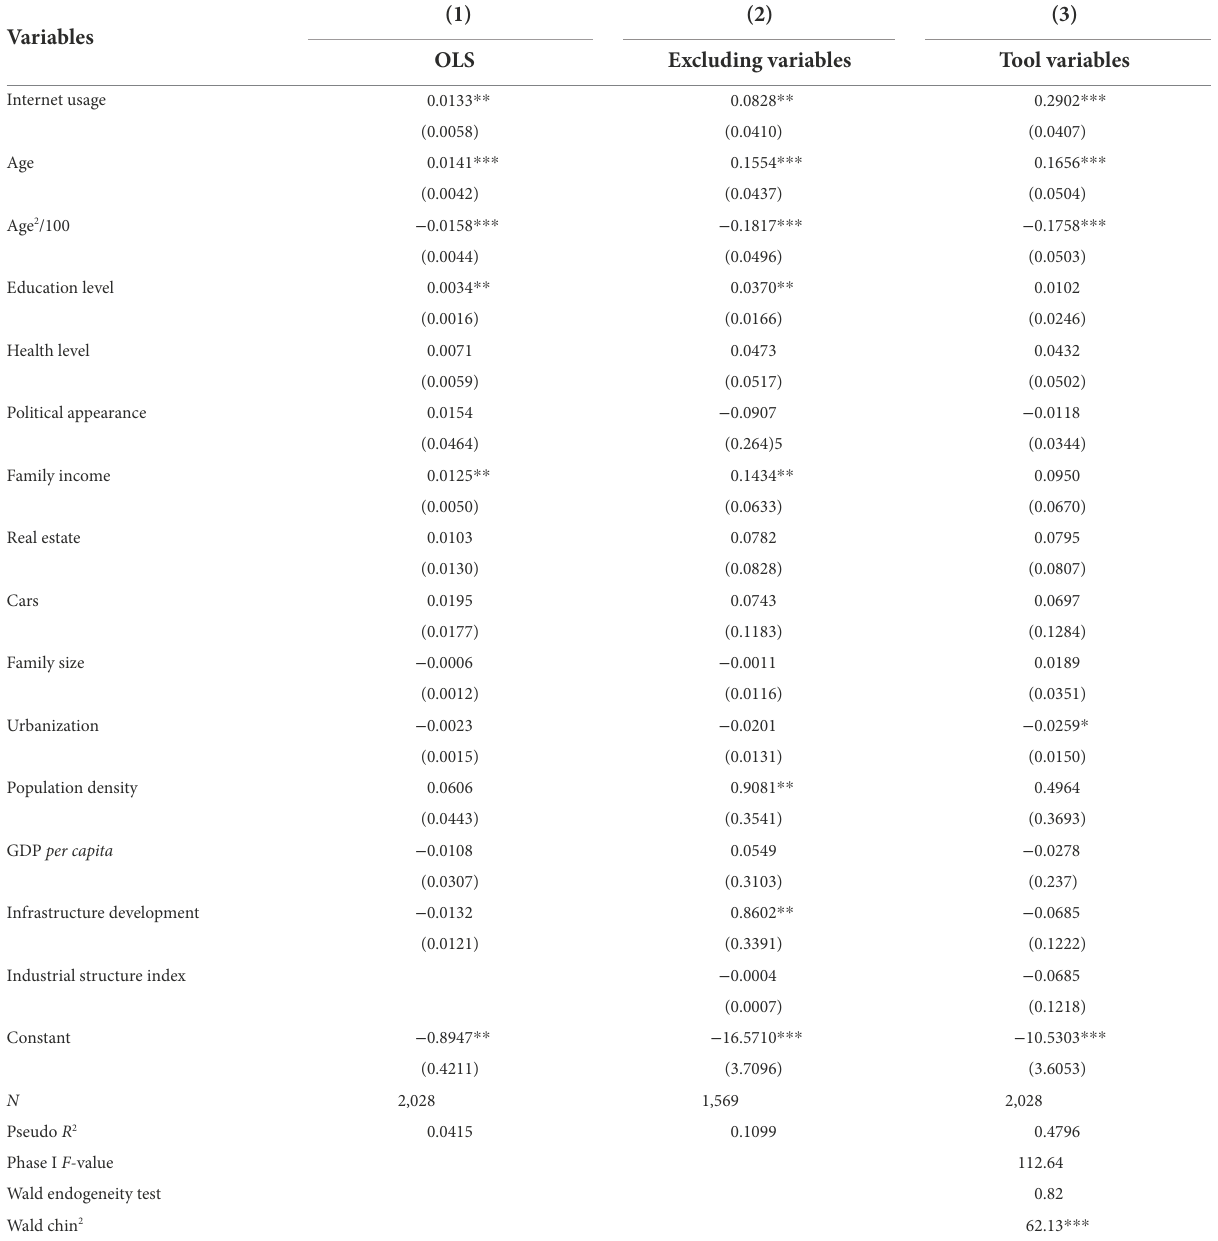
TABLE 4 Robustness